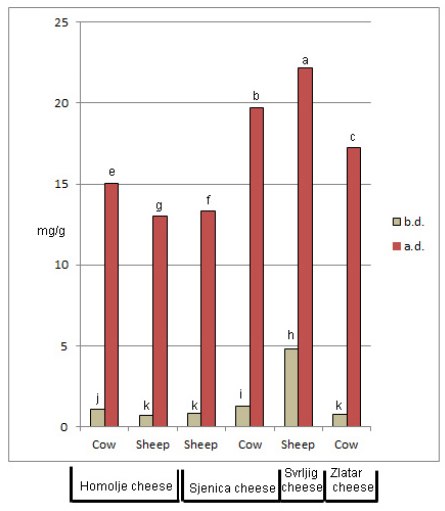
Figure 1. The free amino acid contents of the cheeses before and after in vitro digestion. Data marked with different lowercase letters are significantly different at p < 0.05; b.d., before digestion; a.d., after